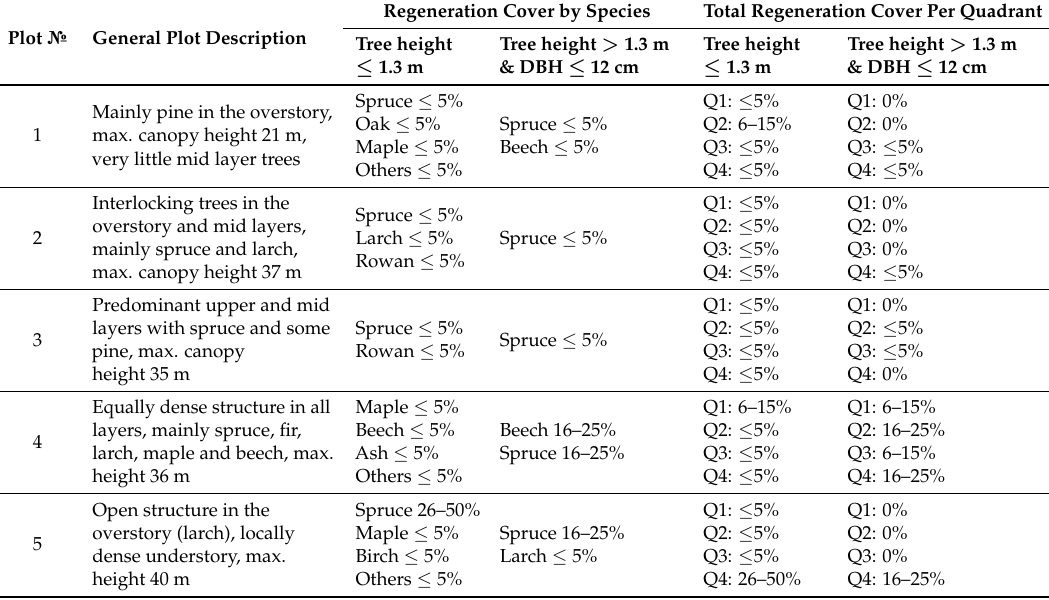
Table 1. Overview of the characteristics of each sample plot. The table lists general structural forest information as well as characteristics of the regeneration cover on the plots and the single quadrants. Plot № General Plot